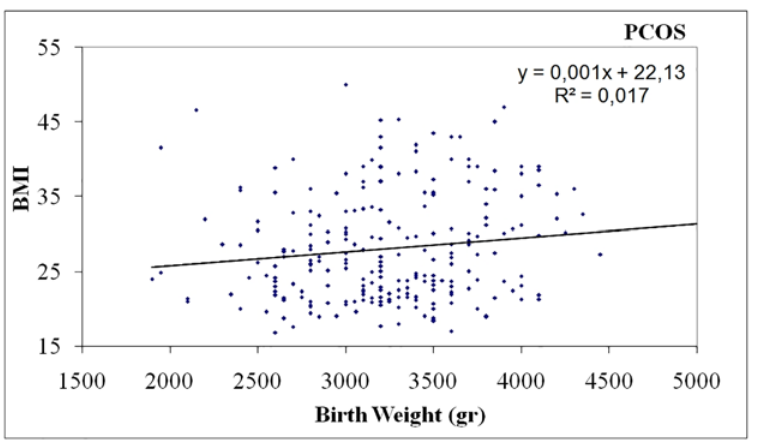
Fig 3. Positive correlation of birth weight with BMI in women with PCOS.